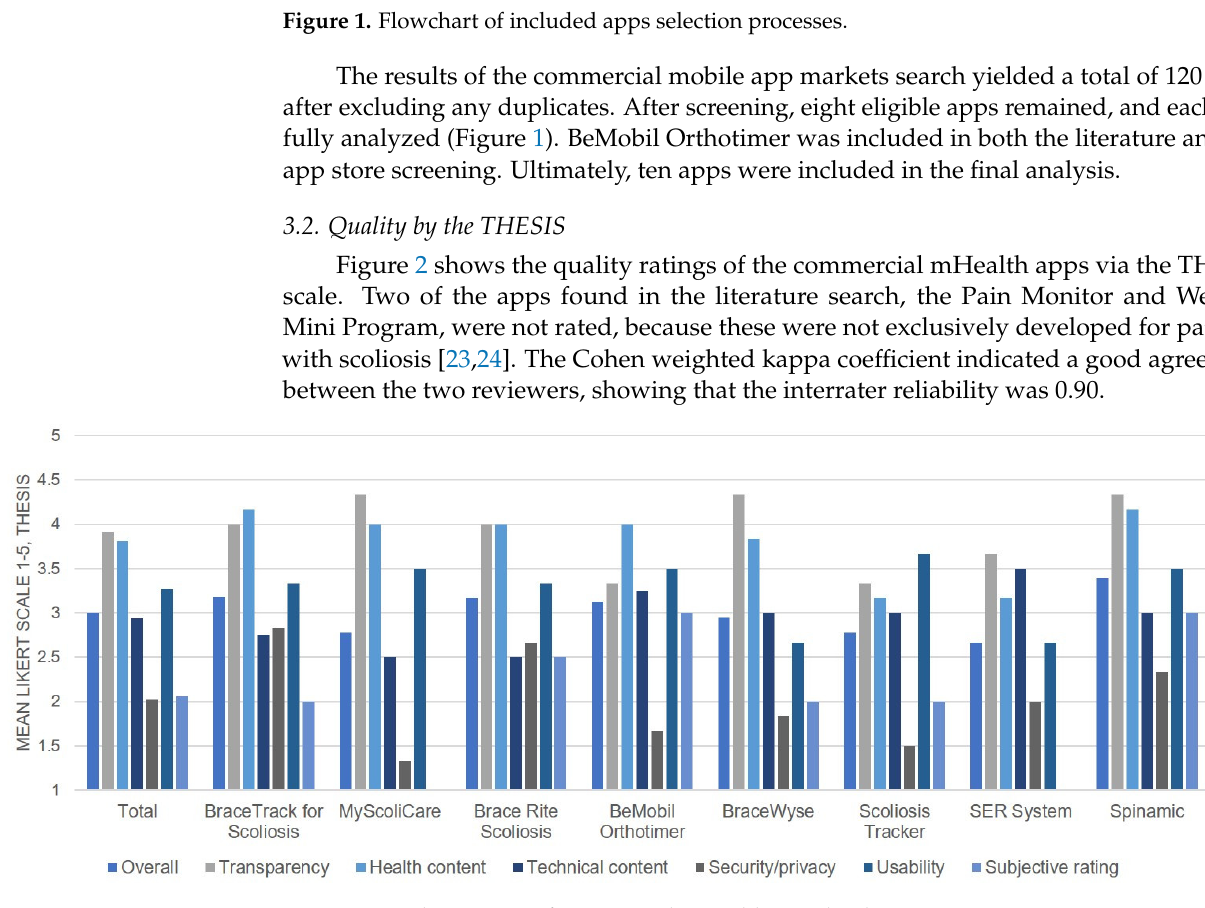
Figure 2. Quality ratings of commercial mHealth apps by the THESIS.